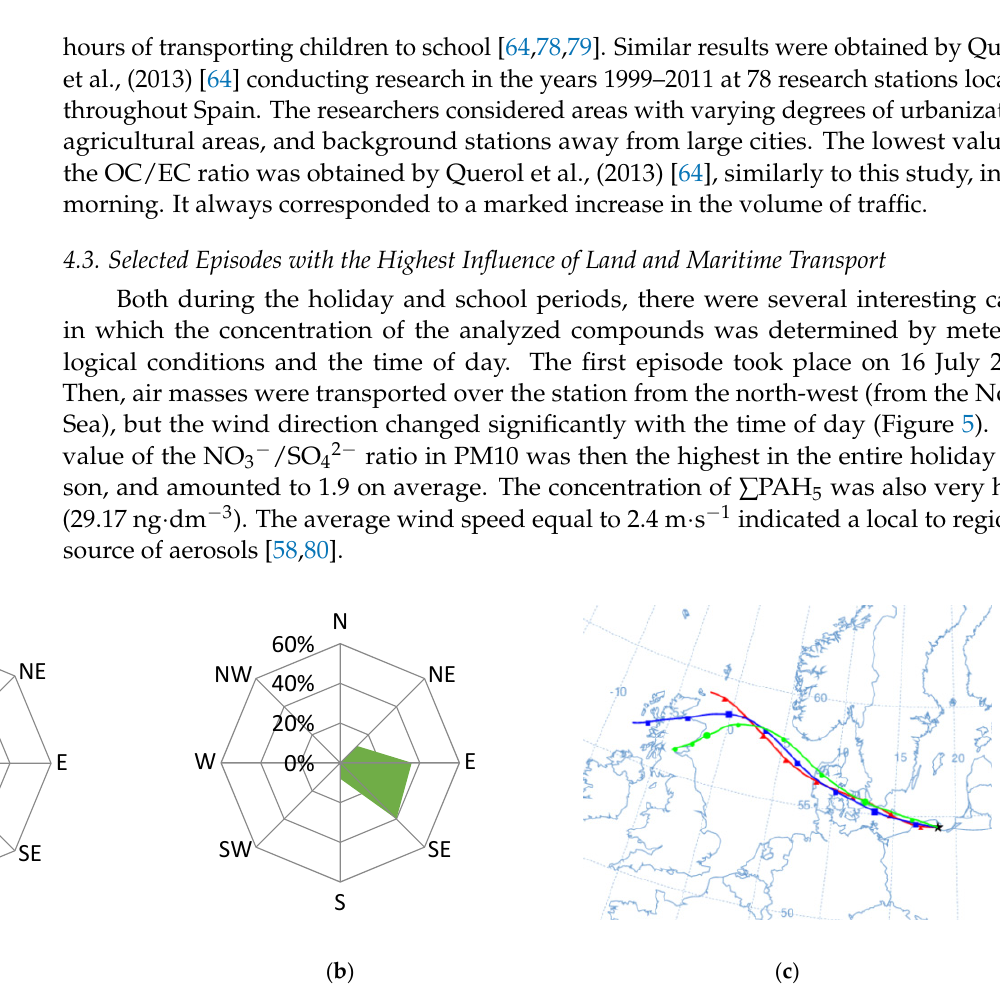
Figure 5. Dominant wind direction in the morning ( a ) and the afternoon ( b ) and the dominant air masses ( c ) on 16 July 2015 in Gdynia.